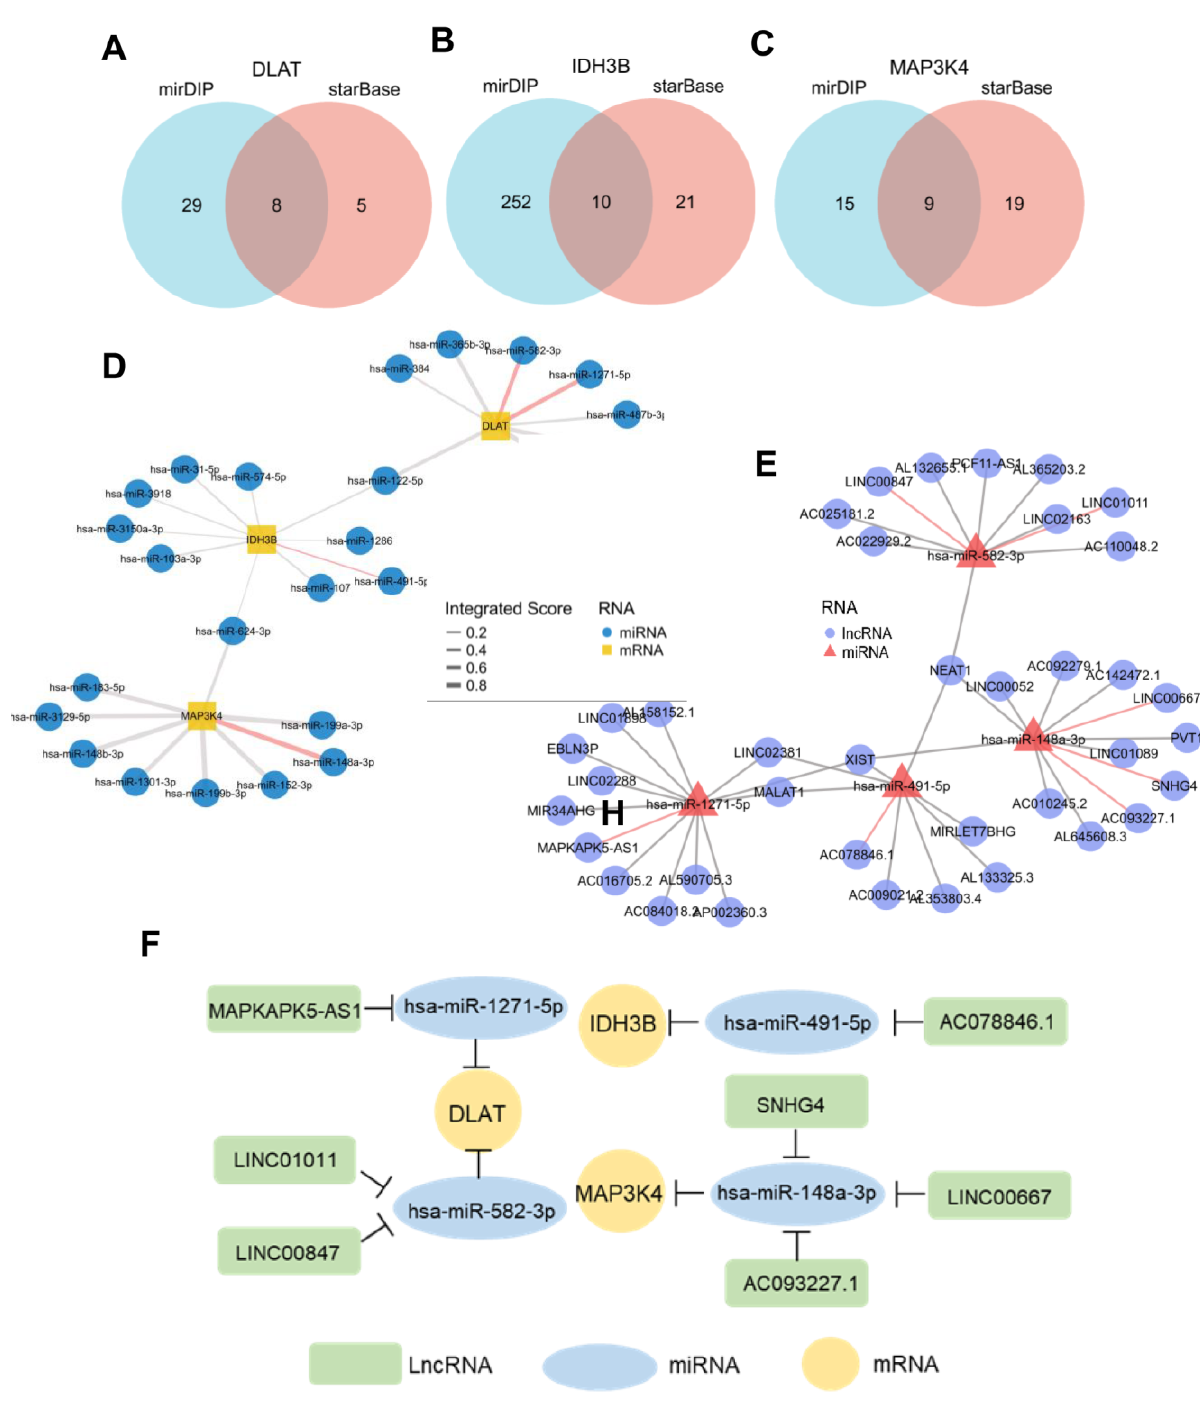
Figure 8. Prediction of potential ceRNA network. ( A – C ) Venn diagram found 8 potential miRNAs of DLAT, 10 potential miRNAs of IDH3B, and 9 potential miRNAs of MAP3K4. ( D ) Network for miRNA–mRNA interactions. Red edges represent the miRNAs with prognostic values in TCGA-LIHC. ( E ) Network for miRNA–lncRNA interactions. Red edges represent the miRNAs with prognostic values in TCGA-LIHC. ( F ) The potential mRNA–miRNA–lncRNA competing endogenous RNA (ceRNA) triple regulatory network associated with the prognosis of HCC.